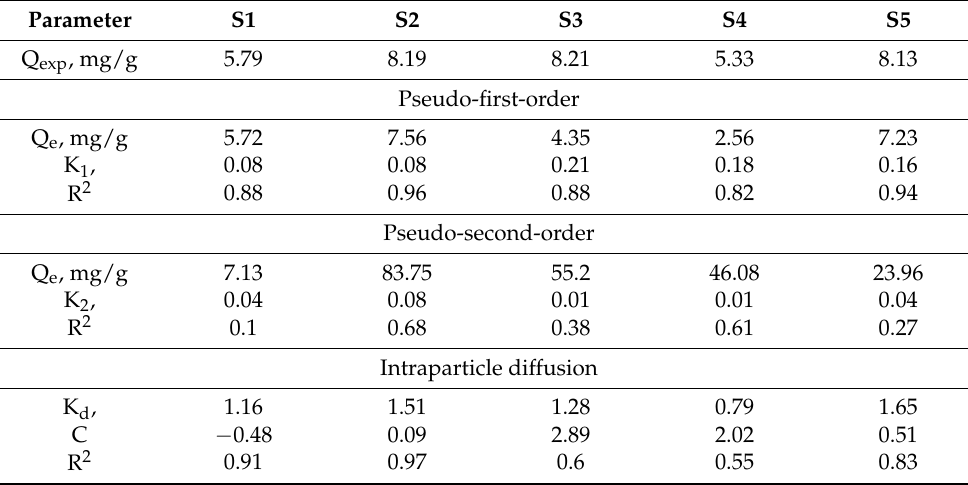
Figure 6. Photocatalytic performance of synthesized catalysts for destruction of Rhodamine B ( a ), Reactive Red 6C ( b ), and Methylene Blue ( c ). Table 5. Kinetics parameters of Reactive Red 6C dye sorption onto the synthesized